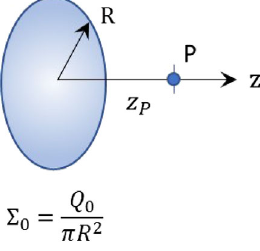
FIG. 3. Parameters of a thin disk of charge.